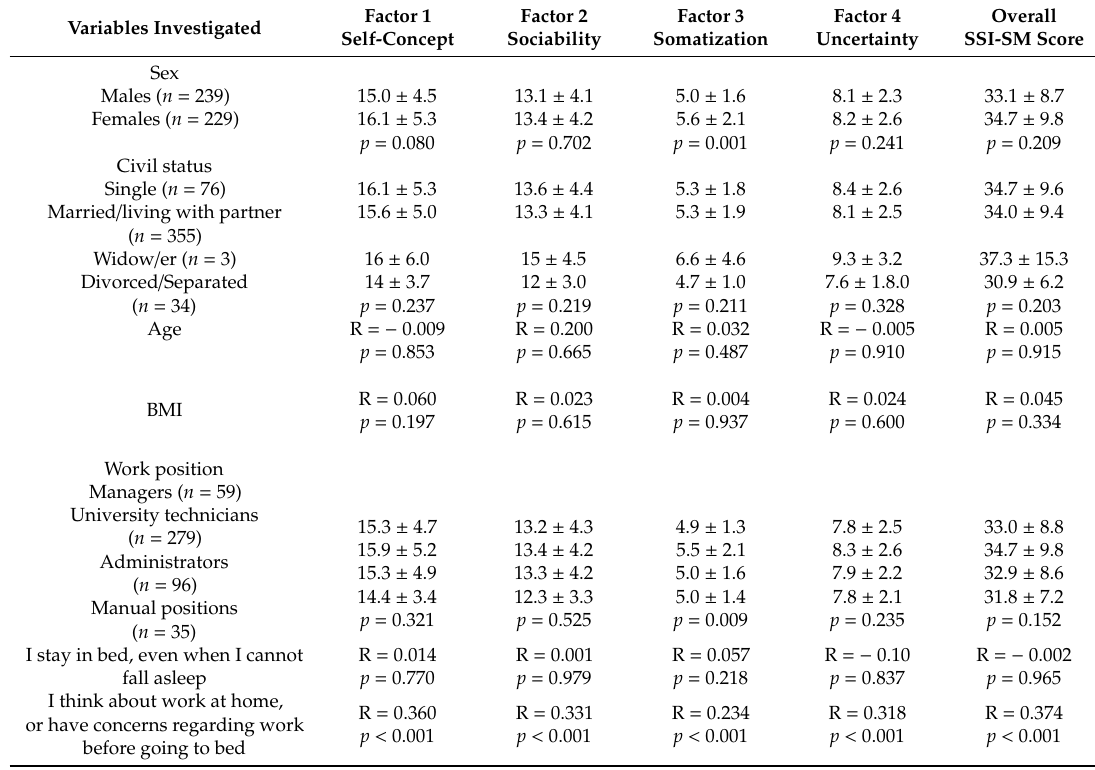
Table 2. Association between the stress questionnaire and personal and work-related factors of public